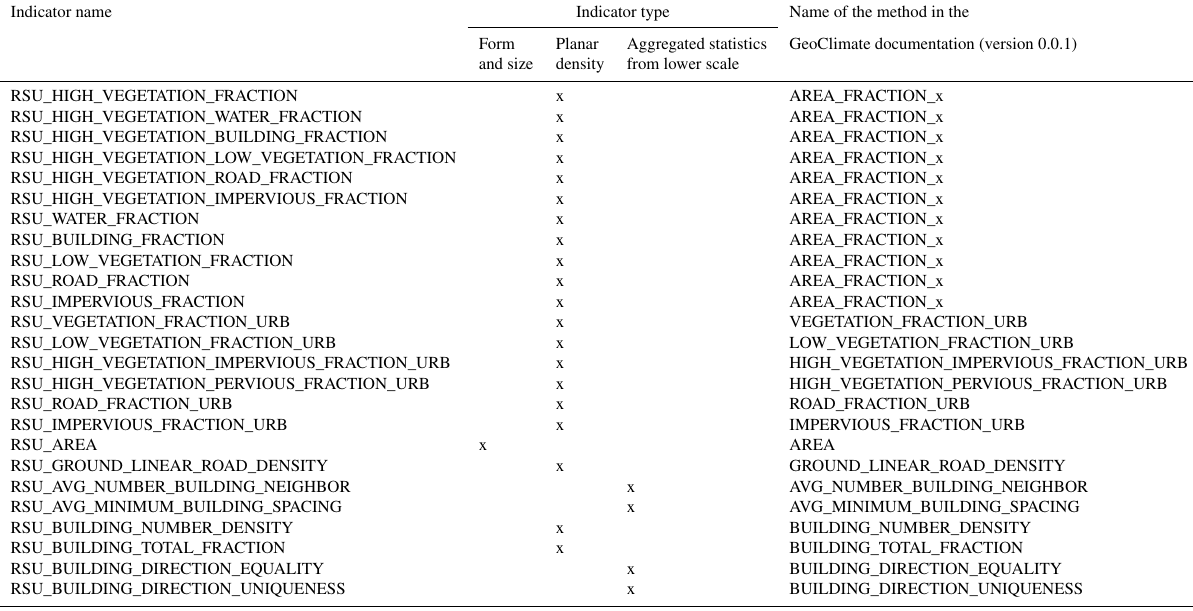
Table A3. List of all TSU scale spatial indicators used as indepen- dent